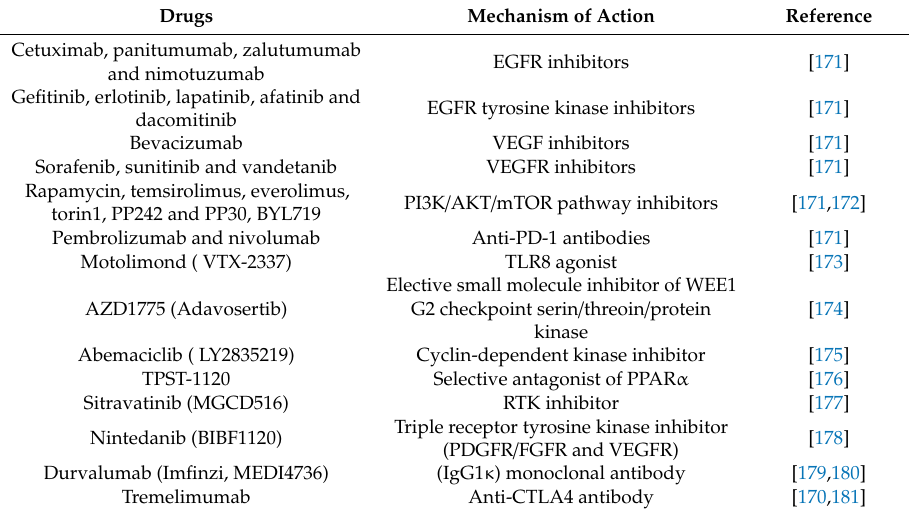
Table 3. Monoclonal antibodies-based therapies for the treatment of head and neck cancer. Drugs Mechanism of